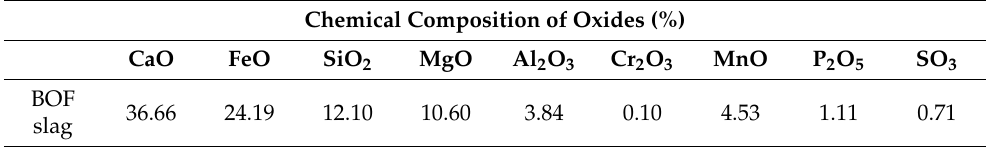
Table 1. Chemical composition of BOF slag.